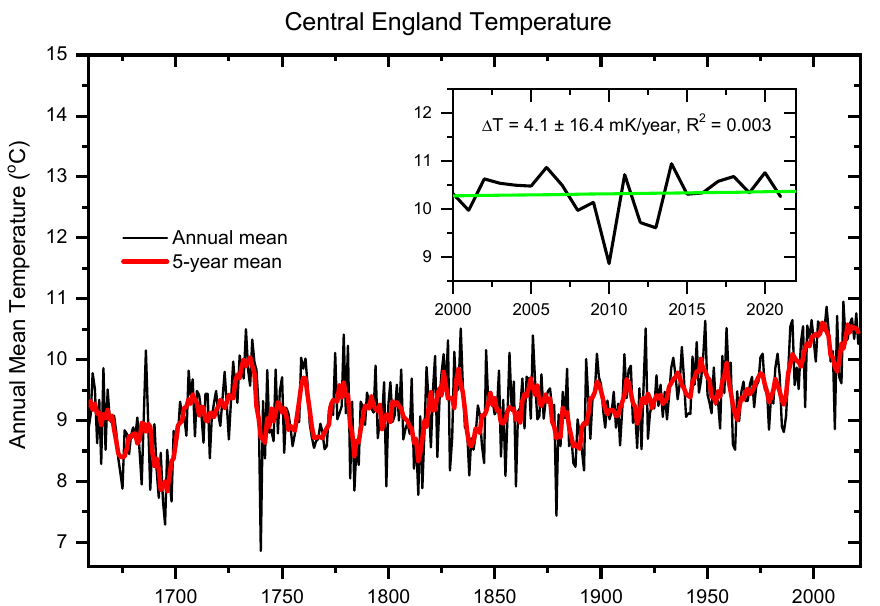
Figure 7. Annual and 5-year mean temperature of the central England representative of a roughly triangular area of the United Kingdom enclosed by Lancashire, London and Bristol for the period of 1659–2021, which is the longest instrumental record of temperature in the world. The inset shows annual temperatures in 2000–2021 (the black curve) and a linear fit to the observed data (the green line), with the slope ∆ T (changed temperature per year) and R 2 value indicated.